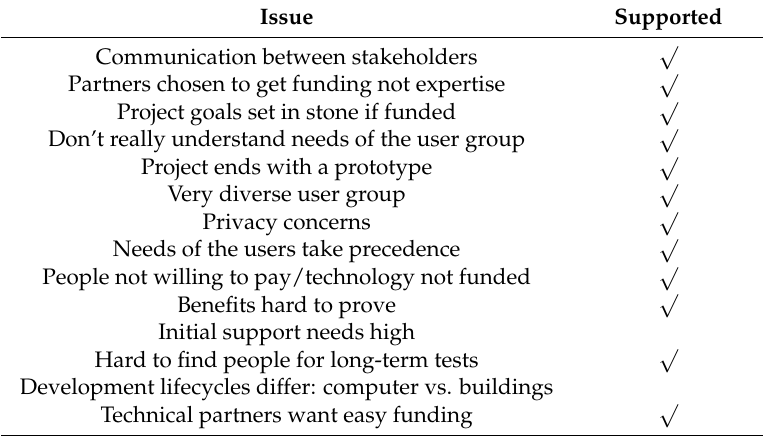
Table A4. Issues included on interactive poster to gain support for